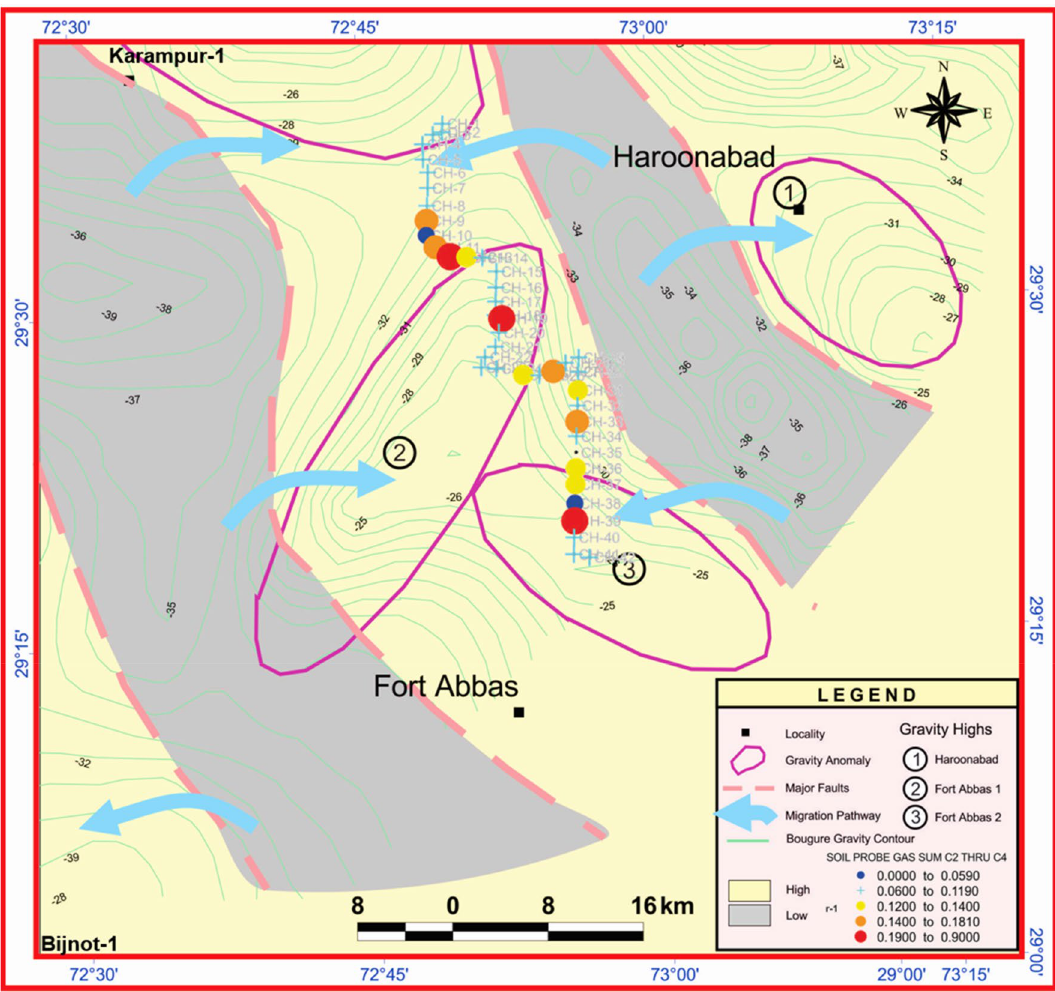
Figure 14. Overlapping C 2 –C 4 hydrocarbon anomalies on the interpreted gravity anomaly map. Surfer (www. golde nsoft ware. com) and CorelDRAW X5 (www. corel draw. com) were used to create the illustration.